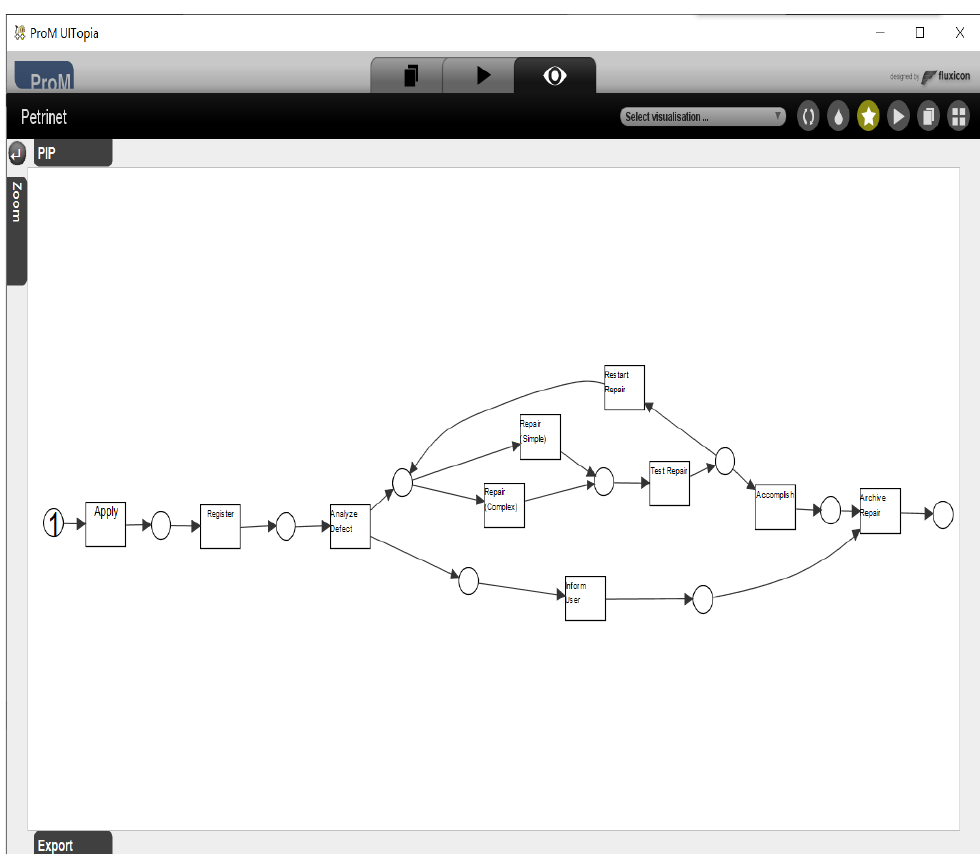
Figure 10. The service process model of telephone repair.